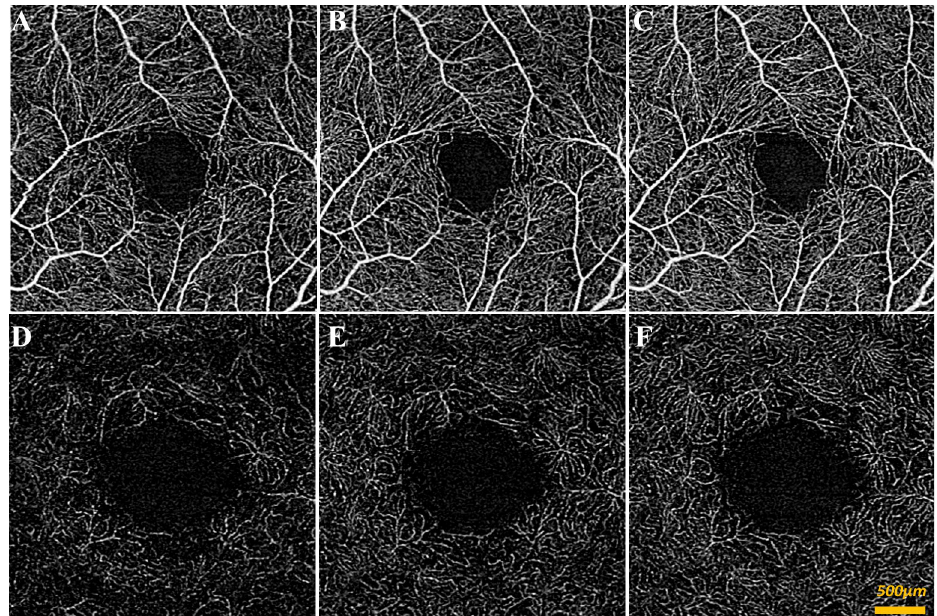
Fig 2. SS-OCTA of control subject during different gas conditions. (A-C) 3x3mm en face superficial retinal layer image of blood flow around central macula during oxygen condition (A), room air condition (B), and carbon dioxide condition (C). (D-E) 3x3mm en face deep retinal layer image of blood flow around central macula during oxygen condition (D), room air condition (E), and carbon dioxide condition (F). A qualitative increase in signal was apparent in the hypercapnic condition when compared to the other two conditions.